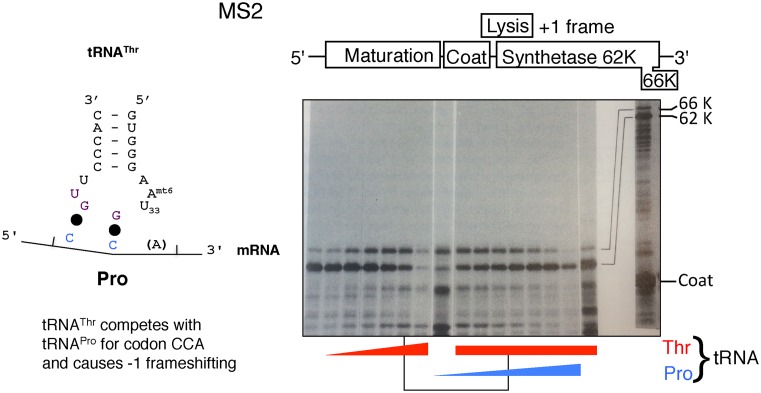
Non-cognate frameshifting. In extracts of E. coli with unperturbed tRNA balance, tRNAThr decodes a proline codon to cause −1 frameshifting that results in synthesis of a 66 K form of the viral encoded component, synthetase, of replicase. Increasing the relative amount of tRNAThr (red wedge) increases the proportion of 66 K with respect to the product of standard decoding (62 K). With elevated levels of tRNAThr (uniform thickness red line) increasing the amount of cognate tRNAPro (blue wedge) decreases the relative amount of 66 K. Anticodon bases 35 and 34 are complementary to the first and second proline codon bases. The normal anticodon of tRNAThr is in purple. A model with 1:6 anticodon loop stacking is discussed in (453). Reprinted in part from Atkins, J.F., Gesteland, R.F., Reid, B.R. and Anderson, C.W. (1979) Normal tRNAs promote ribosomal frameshifting. Cell, 18, 1119–1131 with permission from Elsevier.